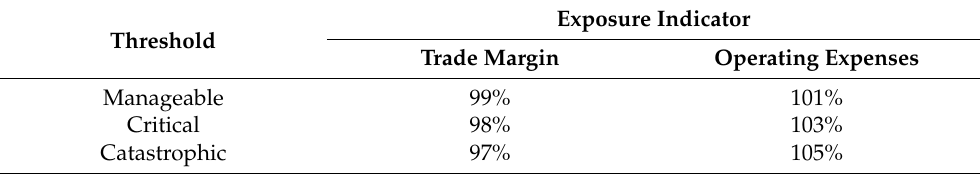
Table 1. Exposure Indicators for the TELCO (Telecommunications Company).